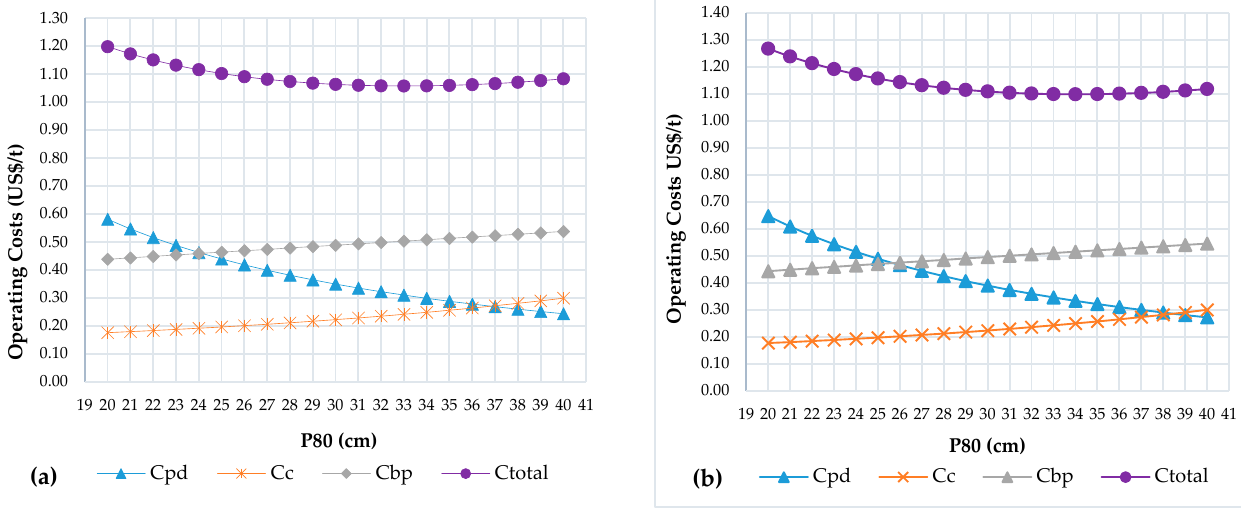
Figure 5. Drilling and blasting, loading and primary crushing operating costs as functions of P 80 for ( a ) JAC and ( b ) JEC.